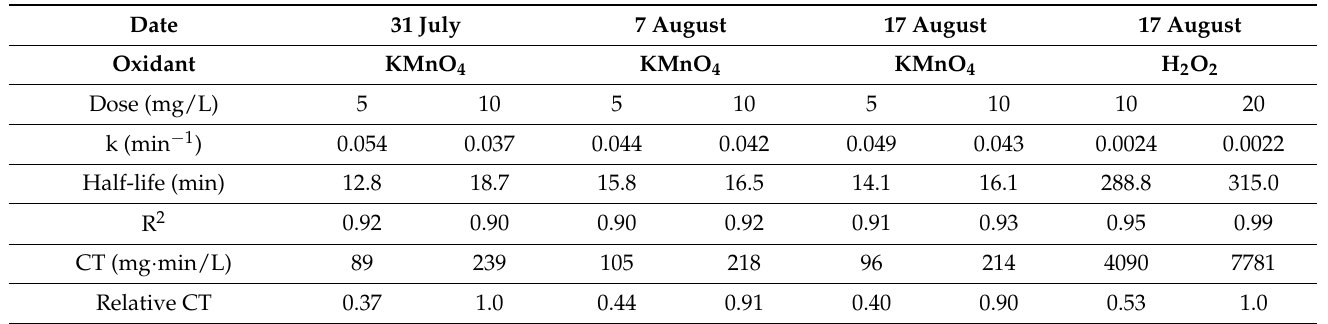
Table 2. Apparent decay rate constant in cyanobacteria-laden sludge oxidation. Contact times: KMnO 4 : 1 h, H 2 O 2 : 24